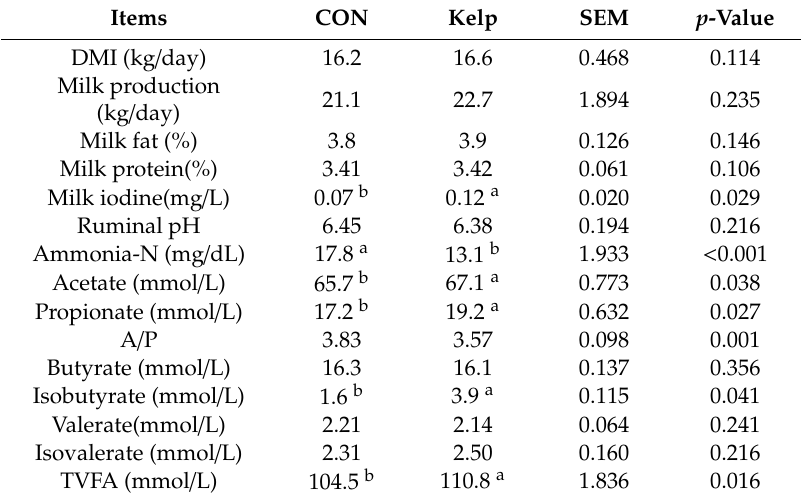
Table 2. E ff ects of kelp powder on animal productivity and ruminal